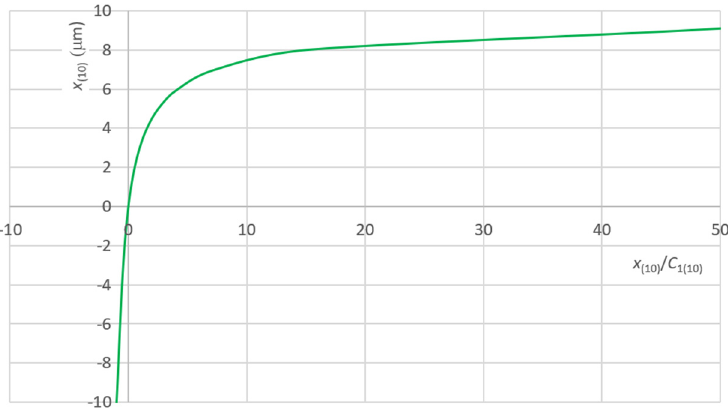
Figure 7. Variation of the parameter x (10) as a function of the x (10) / C 1(10) ratio, assuming that the eccentricity value e (10) = 10 µm.